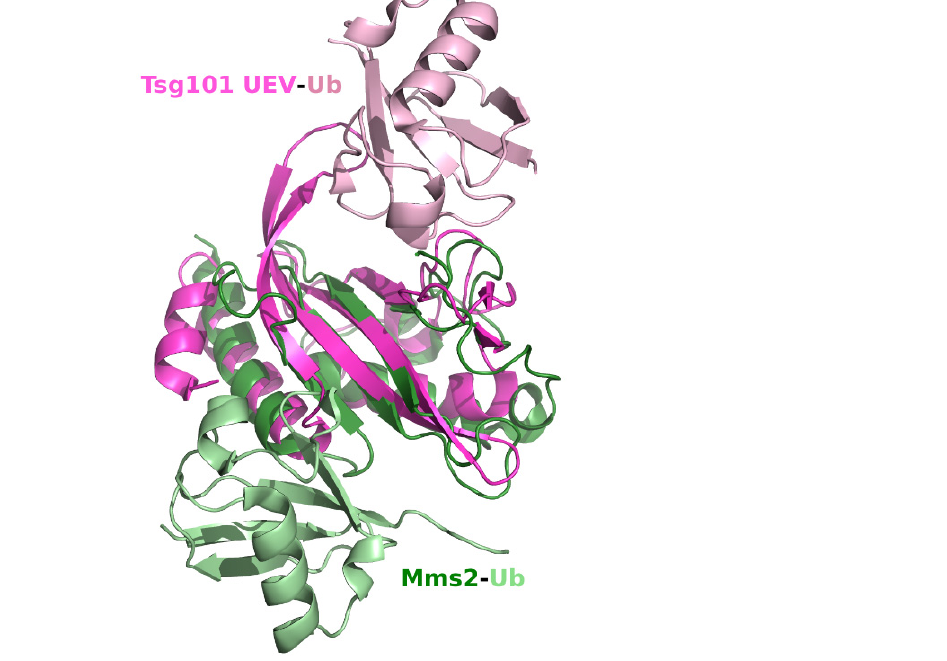
Figure 3. Superimposition of the h Tsg101 UEV domain complexed to Ub and h Mms2 complexed to Ub. Tsg101 is pink, Mms2 is green and the two Ub molecules in each PDB are lighter versions of the same colors. UEV-Ub, PDB ID: 1S1Q [32]; Mms2-Ub, PDB ID: 1ZGU [46].